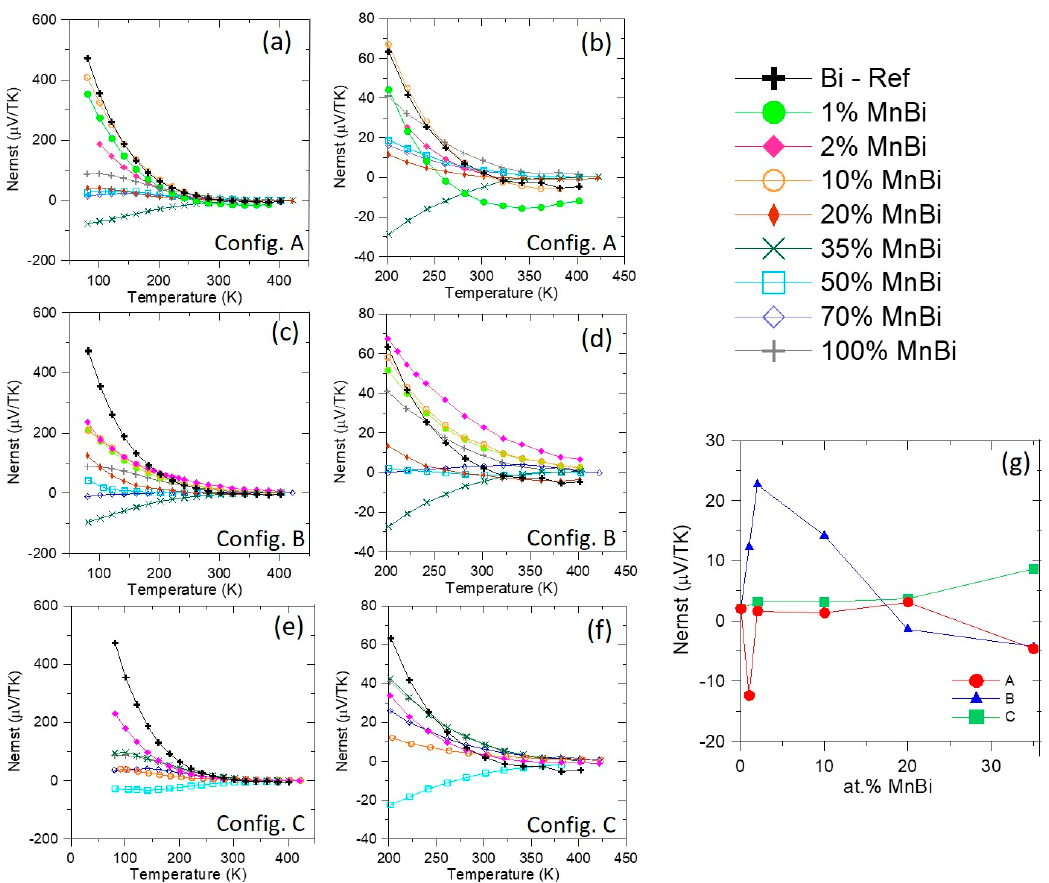
Figure 9. Low-field ( |B| < 0.6 T) Nernst coefficients of the MnBi compositions listed in the legend in the upper right corner in the following configurations: ( a ) configuration A at all temperatures; ( b ) configuration A at higher temperatures; ( c ) configuration B at all temperatures; ( d ) configuration B at higher temperatures; ( e ) configuration C at all temperatures; ( f ) configuration C at higher temperatures. ( g ) shows the Nernst coefficient of each configuration as a function of MnBi composition up to 35 at.%, approximately the percolation limit. We note an enhancement of the Nernst coefficient at T > 220 K for most composite samples in all three configurations when compared to the value of pure Bi, but that enhancement is much greater in configuration B, where an SSE contribution is expected, rather than in A or C.